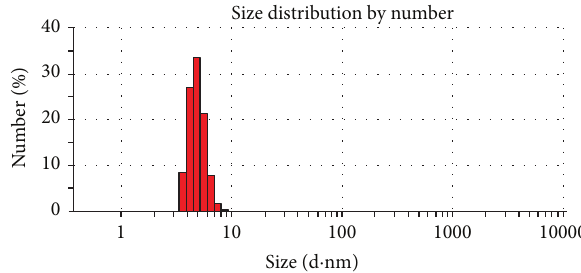
Figure 6: Dynamic Light Scattering measurement of copper nanoparticles sample.